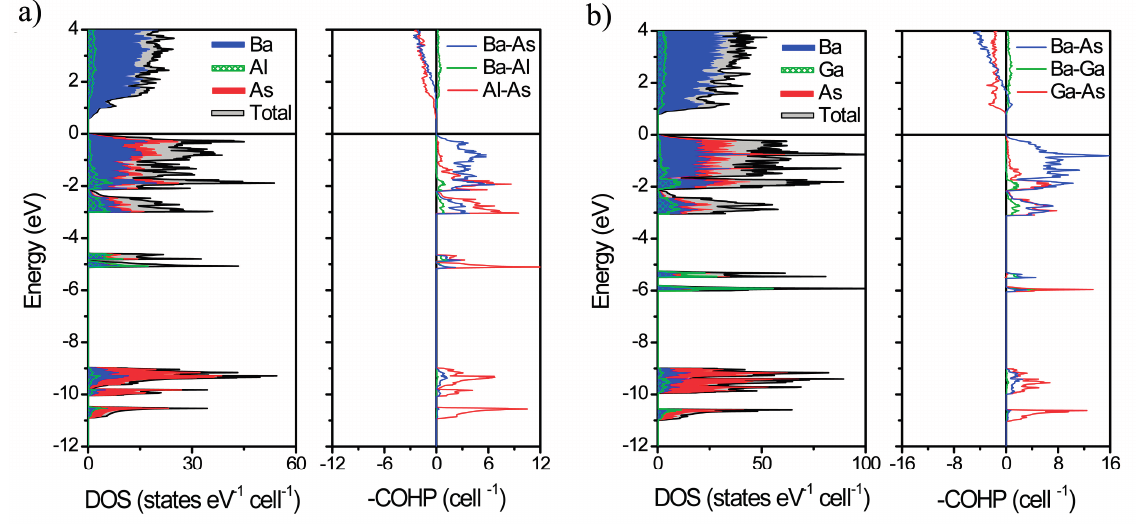
Figure 6. DOS (density of states) and COHP (crystal orbital Hamilton populations) diagrams for (a) Ba 3 AlAs 3 , and (b ) Ba 3 GaAs 3 . The Fermi level is set as the energy reference at 0 eV. Total DOS is shown with a black curve; partial DOS of Ba, Al or Ga, and As are represented by blue, green, and red curves, respectively. The COHP curves of the Ba–As, Al–As (or Ga–As), and Ba–Al (or Ba–Ga) interactions are shown in blue, red, and green, respectively. Since the “inverted” COHP values are plotted, the positive regions represent the bonding interactions, while the negative regions denote antibonding